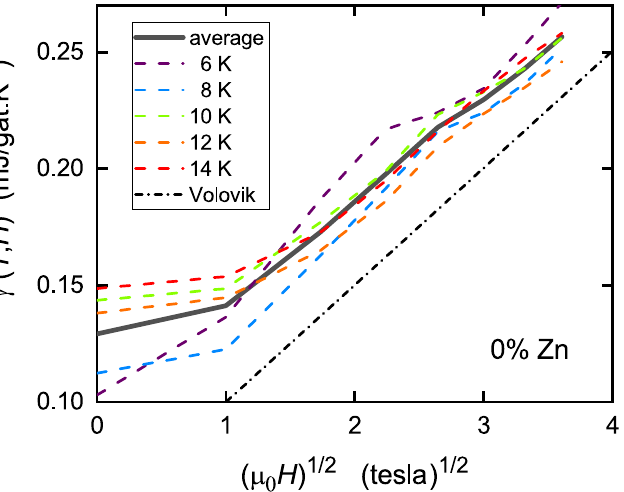
Figure 3. The measured low-temperature specific heat coefficient, γ( T , H ) for pure Y124 plotted as a function of field for T = 6, 8, 10, 12 and 14 K. Above 1 tesla the data is essentially linear, consistent with the Volovik effect 17 . The black dash/dot line shows the expected slope for (cid:31) 0